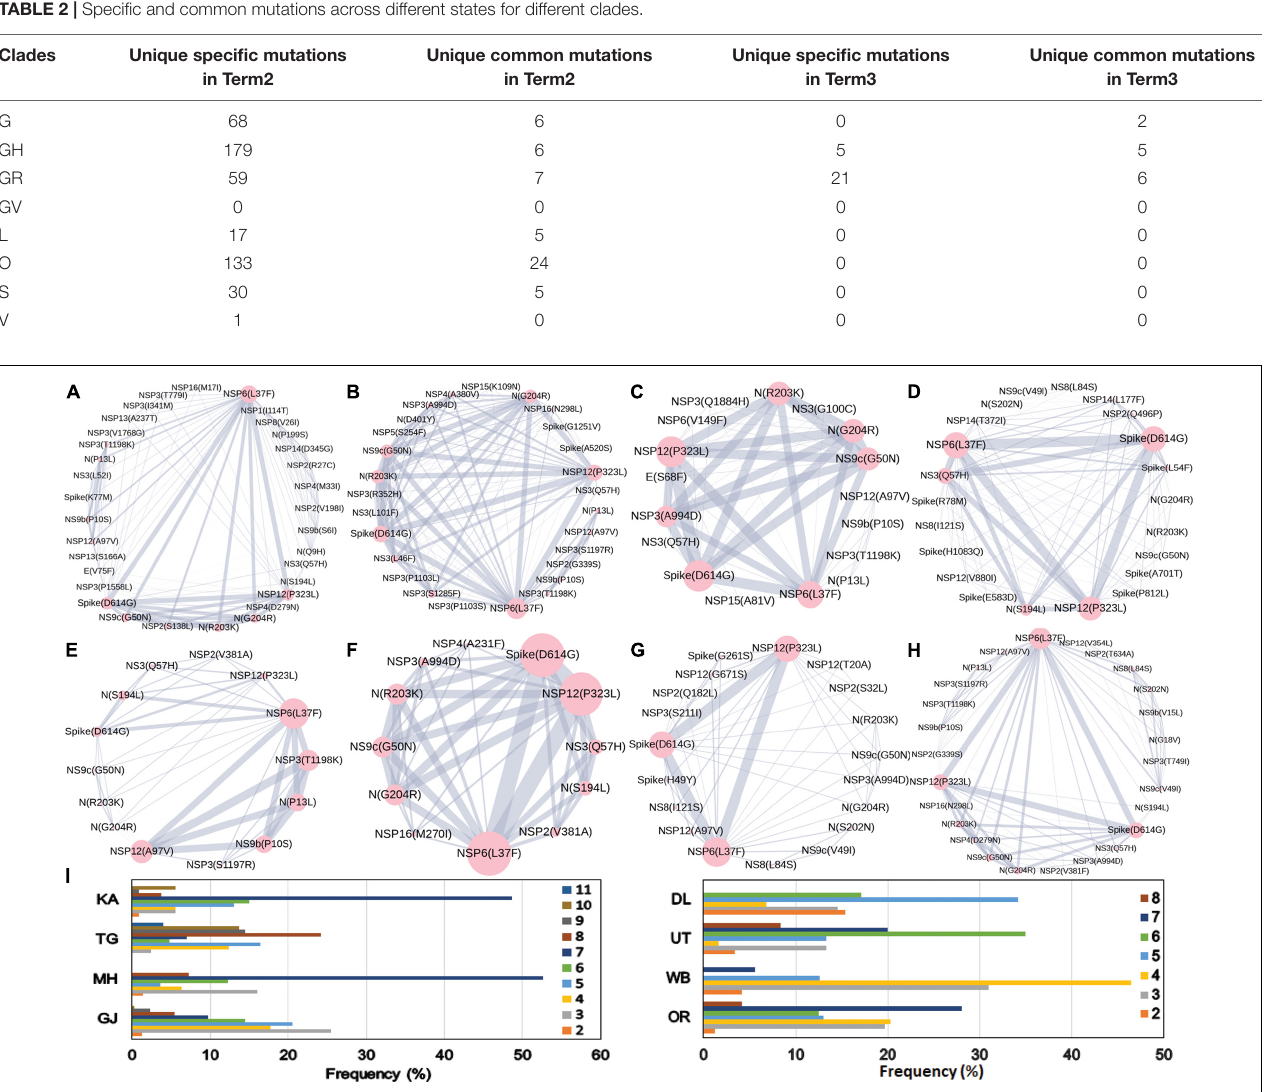
FIGURE 3 | Co-mutation patterns and networks observed within Indian states and union territories (UT) during Term2. The networks of co-mutations for seven states and one UT: (A) Karnataka (KA), (B) Telangana (TG), (C) Maharashtra (MH), (D) Gujarat (GJ), (E) Delhi (DL), (F) Uttarakhand (UT), (G) West Bengal (WB), and (H) Odisha (OR), where each mutation site is marked as a “node” and the co-mutation is represented as an “edge.” The node size indicates the frequency of mutation, while the edge thickness represents the number of times (sequences) a pair of mutation has co-occurred. (I) The bar plot distribution of the actual number of co-mutations within each state and